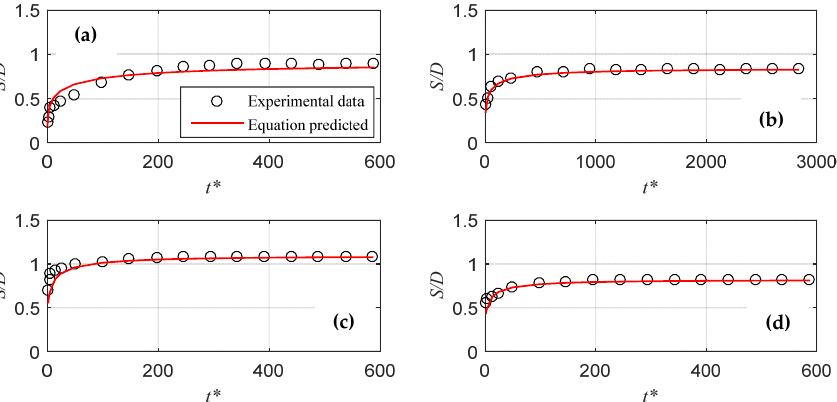
Figure 15. Comparison of temporal scour depth development predicted by the present equation against the experimental data from [28]: ( a – d ) Test 1–4.